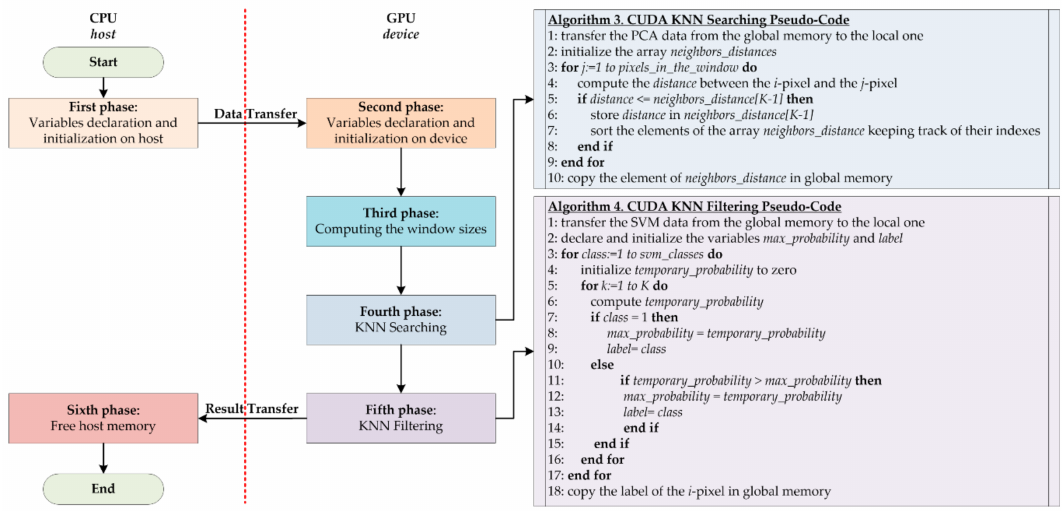
Figure 6. Flow diagram of the parallel implementation of the KNN filtering